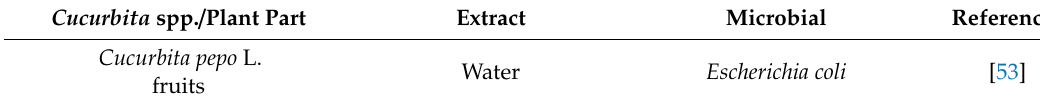
Table 3. Antimicrobial activity of Cucurbita spp. extracts evaluated in